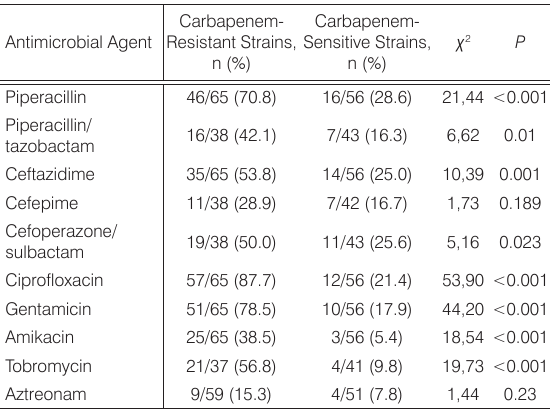
Table 1. Resistance of Carbapenem-Resistant and Carbapenem- Sensitive Pseudomonas aeruginosa strains to Various Antibiotics.